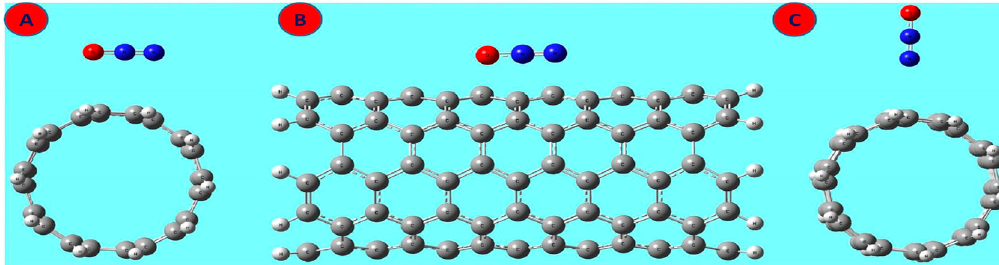
Figure 20. The optimized structures of adsorbed N 2 O from three orientations on intrinsic CNT. ( A ) Vertical (VC) to the nanotube axis; ( B ) Horizontal (HC) to the nanotube axis; and ( C ) The nitrogen atom toward the C–C bond (NC). Reproduced with permission from Reference [88].